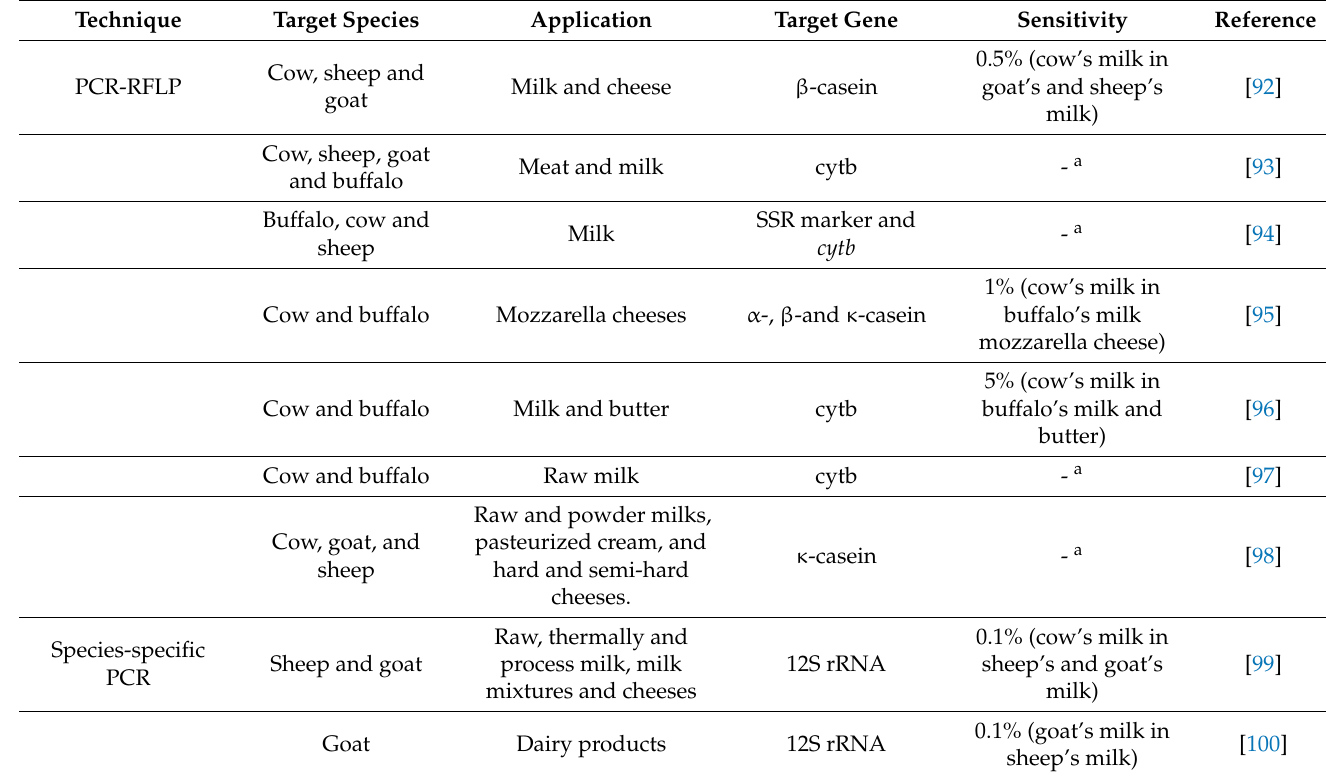
Table 3. Summarized information of reported DNA-based methods applied to species identification in dairy